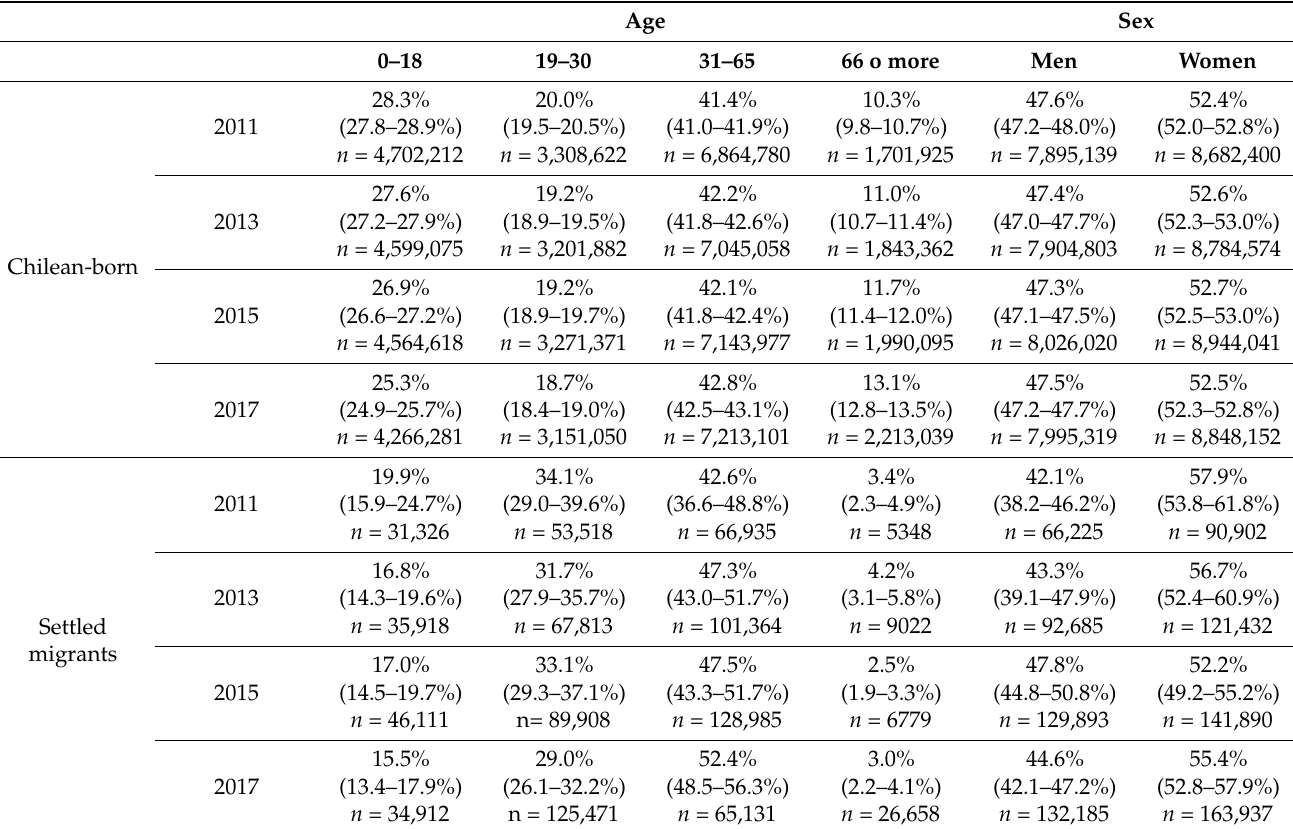
Table 1. Sex and age distribution of Chilean-born population and immigrant population (settled, emerging, and migrants from other countries). Chile